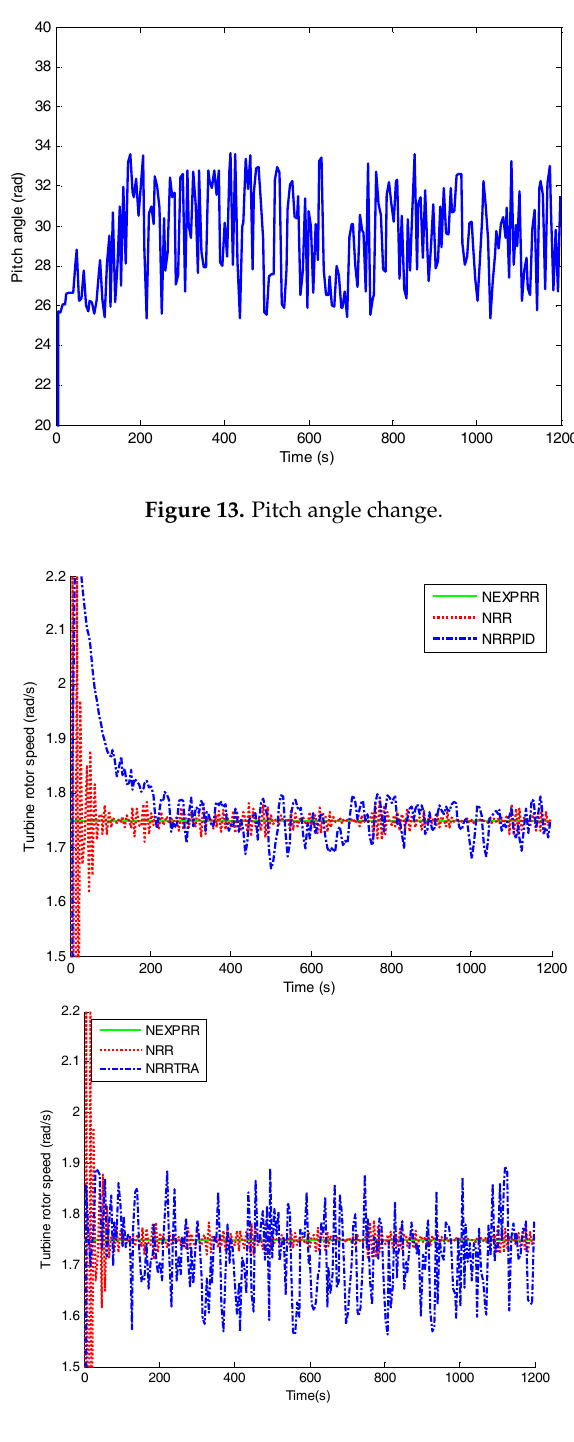
Figure 14. The turbine rotor speed.